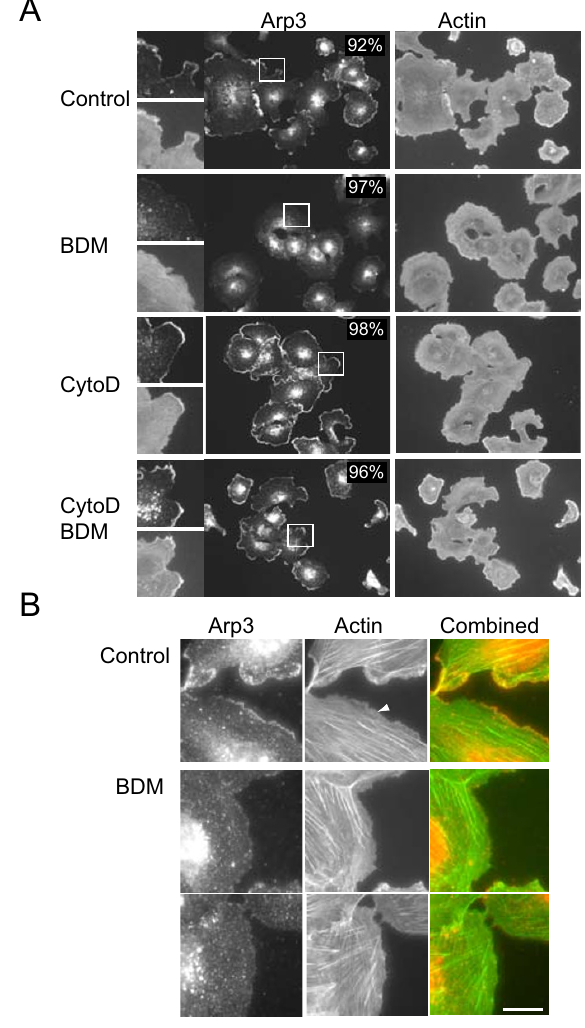
Figure 2 Arp3 is de-localized with BDM treatment. (A) BS-C-1 cells stained for Arp3 and actin after 1 minute of treatment with a media control, BDM, cytochalasin D, or both BDM and cytochalasin D. BDM treatment leads to de-localization of Arp3 and loss of the brightly stained leading edge actin network. Arp3 is not de-localized with cytochalasin D treat- ment or a combination of cyto D and BDM, suggesting that actin dynamics may be required for de-localization. The per- centage of cells with the phenotype pictured is noted for each treatment (n =100 cells). Bar, 50 um. (B) Higher magni- fication of control and two BDM treated fields show actin and Arp3 staining. Actin at the leading edge of control cells (arrow) is denser, suggestive of a well-organized network, and has fewer bundled projections as compared to BDM treatment. Bar, 20